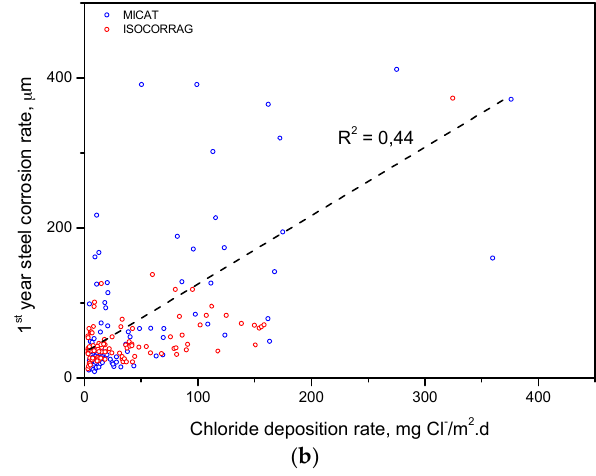
Figure 5 . Relationship between annual steel corrosion and chloride deposition rate in marine test sites including in MICAT and ISOCORRAG databases ( a ); and the same relationship after anomalous data were eliminated ( b ).